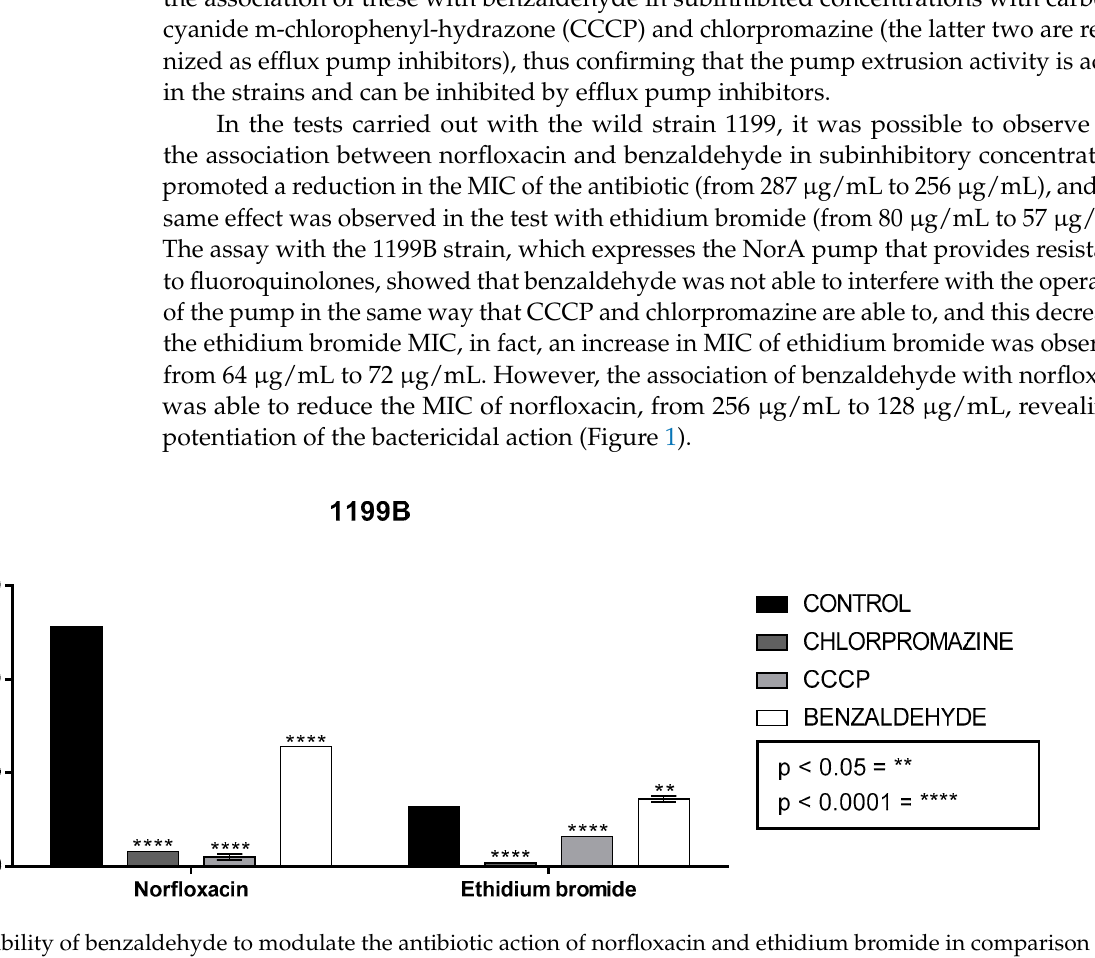
Figure 1. Ability of benzaldehyde to modulate the antibiotic action of norfloxacin and ethidium bromide in comparison with standard inhibitors (Strain 1199B). Legend: carbonyl cyanide m-chlorophenylhydrazone (CCCP). The values represent the geometric mean ± S.E.M. (standard error of the mean). Two-way ANOVA was used, followed by Bonferroni’s post hoc. ** = p < 0.05, **** = p <